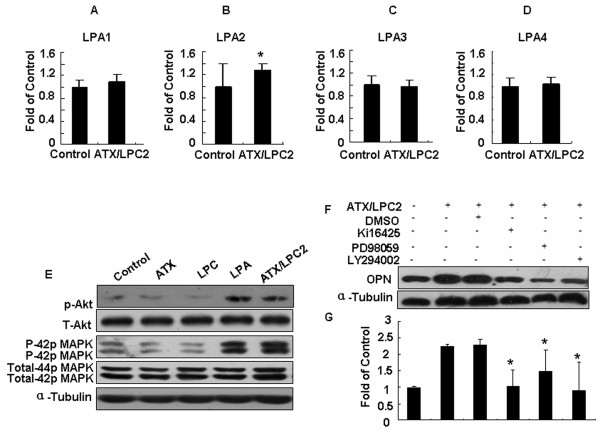
ATX/LPC-regulated OPN expression is mediated by LPA2 receptor and activation of Akt and MAPK/ERK. SGC7901 cells were exposed to ATX, LPC, LPA, ATX/LPC2 or DMEM/0.1% BSA for 24 hours or 30 min, and then total RNA and protein were extracted for real time-PCR (A-D) and Western blot (E, F), respectively. (E) Immunoblotting was performed to detect the phosphorylation status of ERK and Akt. Total ERK and Akt levels were assessed as control. (F) The effects of the LPA inhibitor, ERK inhibitor and Akt inhibitor on ATX/LPC2-induced OPN expression in SGC7901 cells. SGC7901 cells were treated with Ki16425, PD98059, LY294002 or DMSO (0.1%; a solvent control) for 45 min prior to ATX/LPC2 treatment. 24 hours following stimulations, OPN expression was measured by Western blot analysis. All experiments were performed in triplicate and a representative result is shown here. Figure 2G showed the densitometric ratio of OPN protein/α-tubulin. Statistical analysis was performed using Student's t test. *p < 0.05.